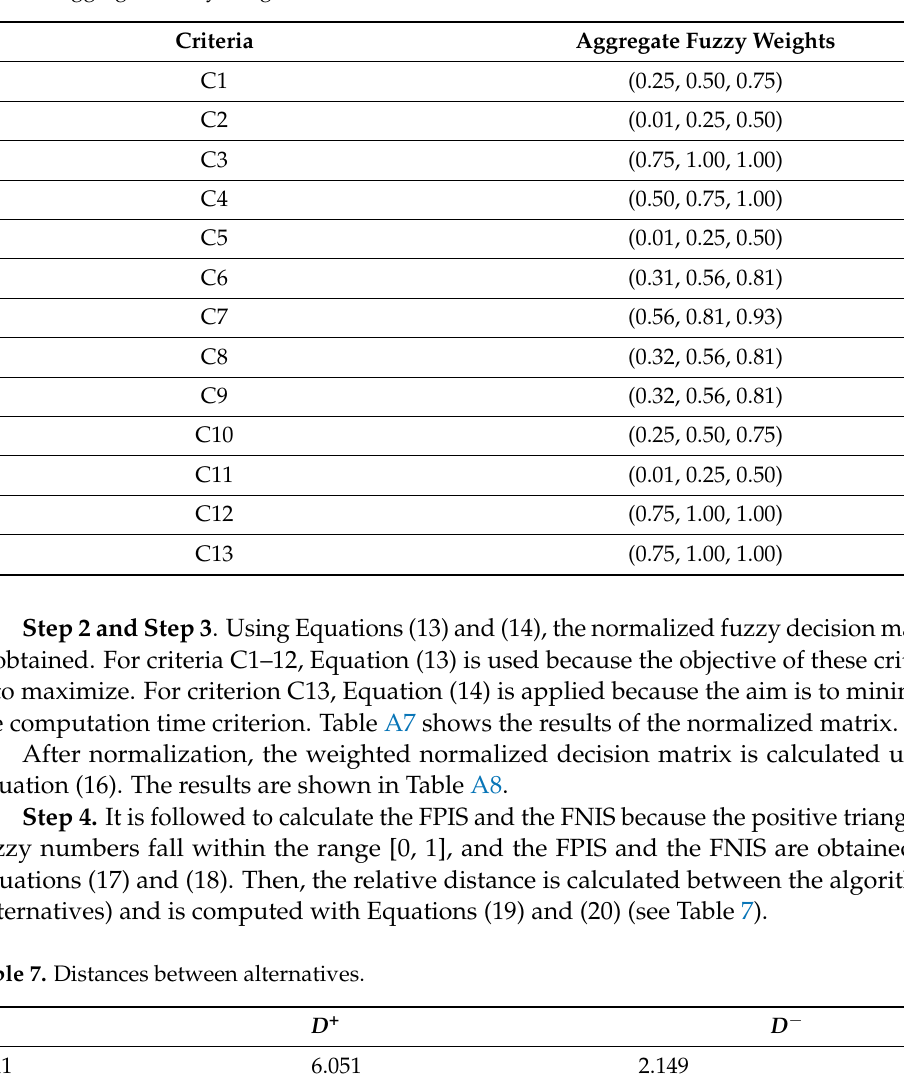
Table 6. Aggregate fuzzy weights for each criterion.